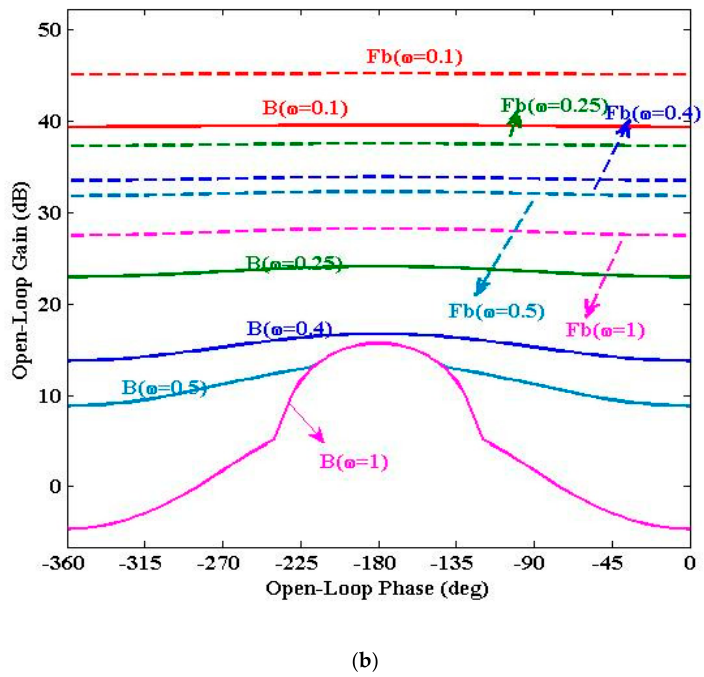
Figure 5. ( a ) The nominal loop-shaping for channel-11 (lower magnet). Here, B ( ω ) denotes the bounds at each design frequency ω and the numbers denoted in bold (1,2,3,4) at the nominal loop transmission function path denotes the phase shift, and ( b ) bound comparison between the proposed method and the pure feedback design method. Appl. Sci. 2019 , x , x FOR PEER REVIEW